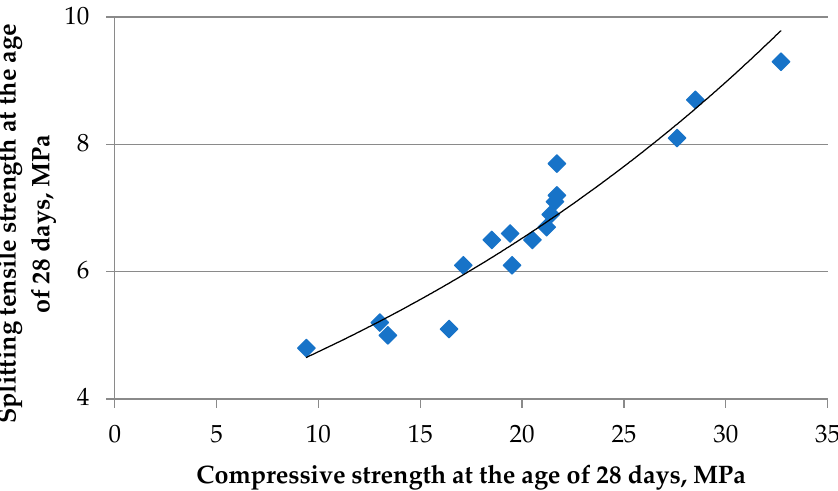
Figure 7. Relationships of tensile strength when splitting to compressive strength at the age of 28 days.